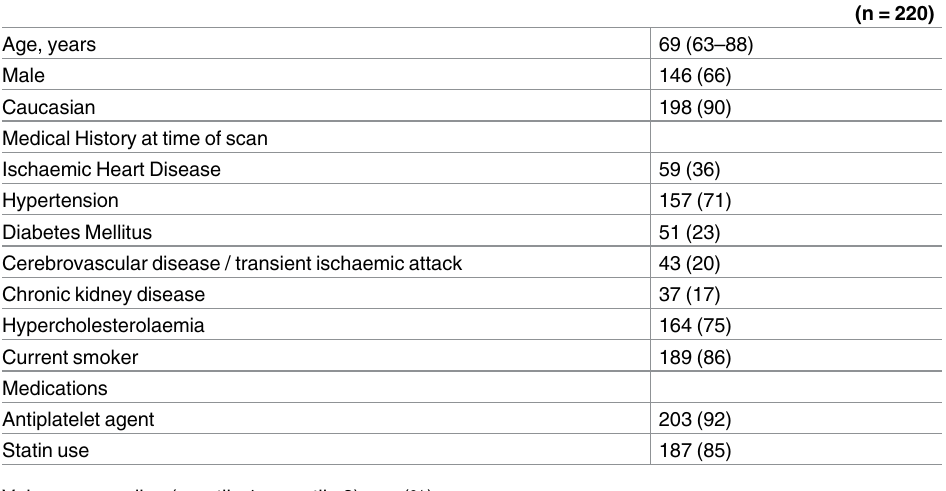
Table 1. Baseline demographics.